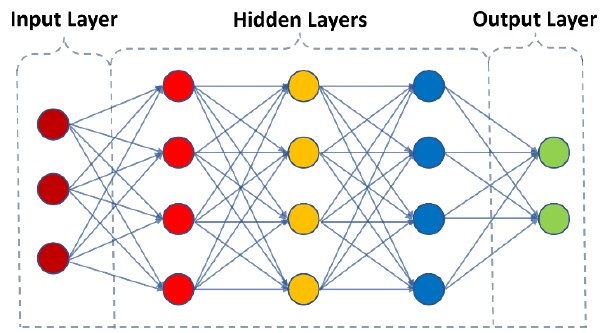
Figure 7. The general structure of an Artificial Neural Network (ANN) [25].